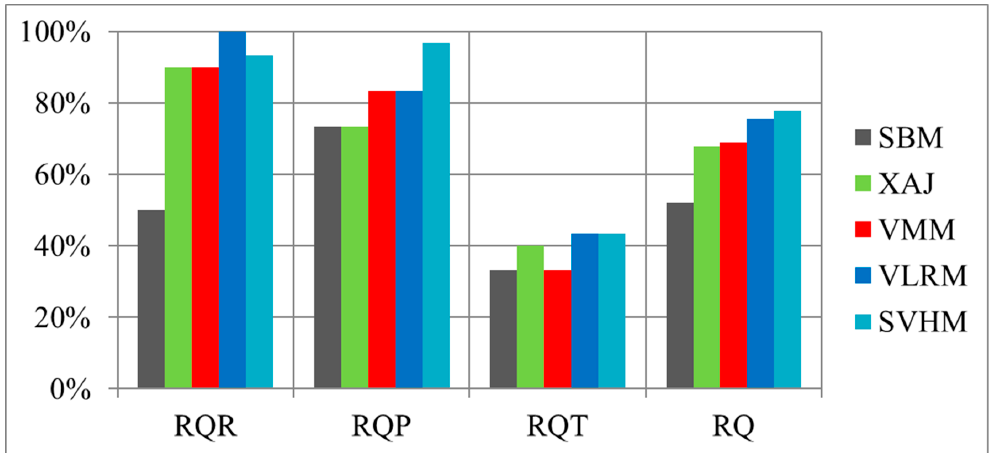
Figure 10. Comparisons of performance measures for different models in simulating all flood events in Xiuwu Basin (Note: RQR, RQP and RQT denote the ratio of qualified total runoff, ratio of qualified flood peak and ratio of qualified appearance time for flood peak, respectively. RQ is the mean of RQR, RQP and RQT. RQ can be classified by A grade: 85–100%, B grade: 70–85% and C grade: 60–70%